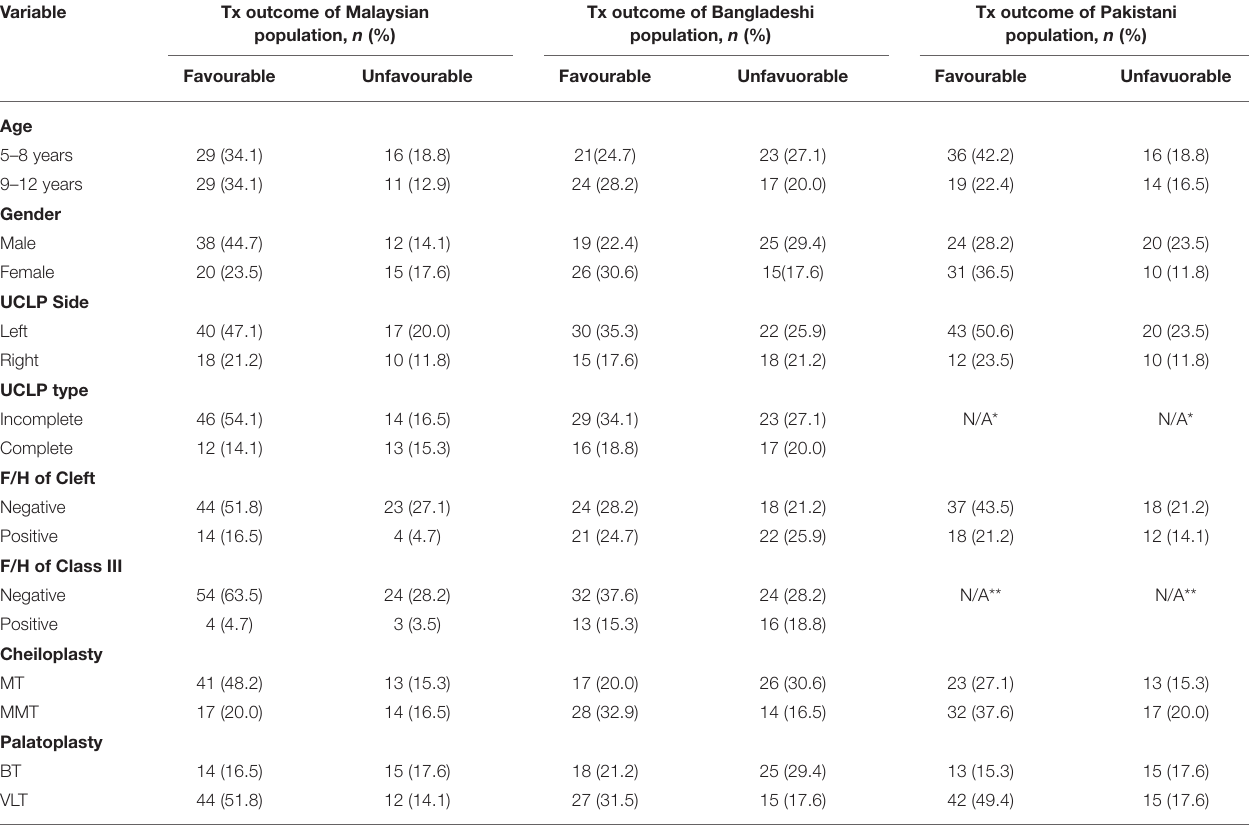
TABLE 3 | Distribution of subjects with multiple factors in favourable and unfavourable groups using GY in Malaysian, Bangladeshi and Pakistani UCLP children. Variable Tx outcome of Malaysian population, n